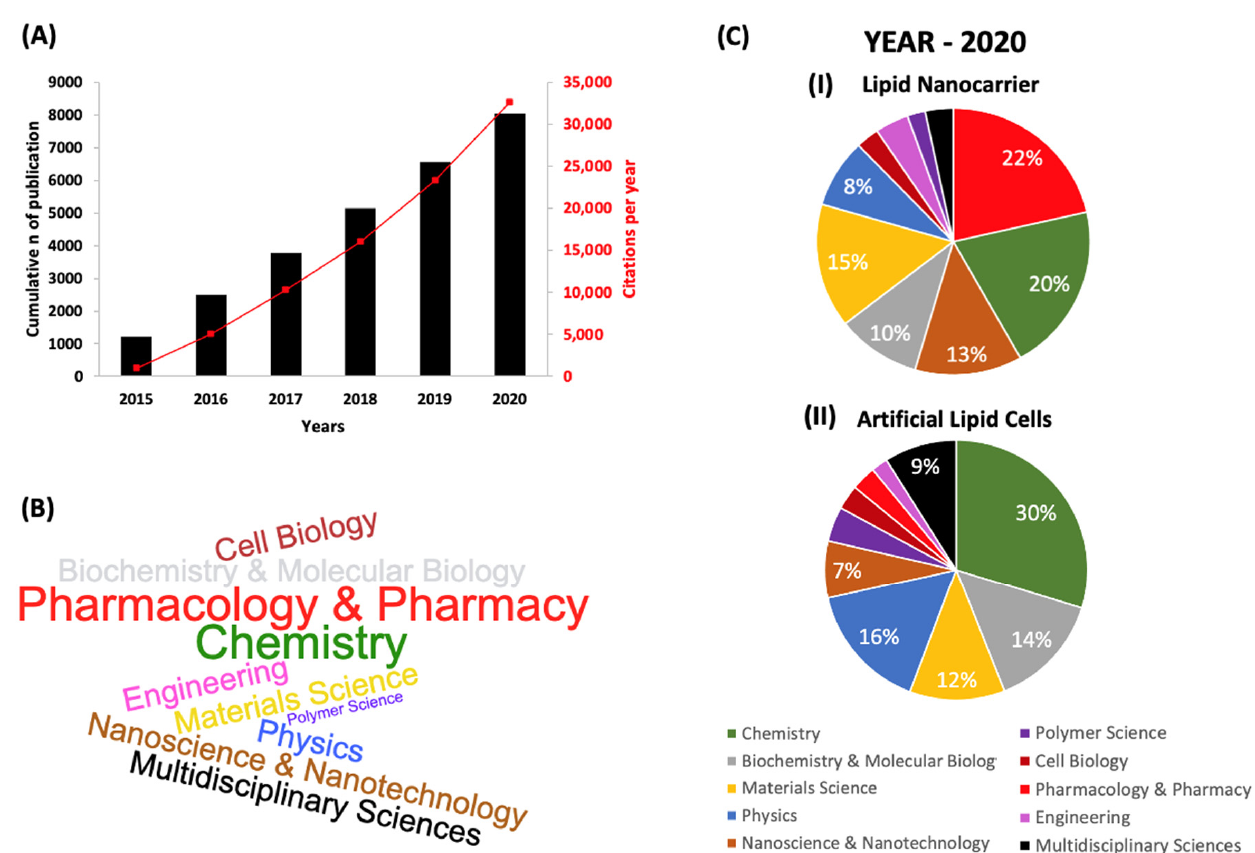
Figure 1. ( A ) Microfluidic publications over the last five years concerning studies with “Microflu- idic*” as a search term along with “Liposome”, “Lipid-nanoparticle”, “Giant Lipid Vesicle or Giant Liposome”, and “Artificial Lipid Cells”. The keywords were searched for on the Web of Science (WoS) analytics report system from Thomson Reuters. The symbol * takes into account permutations of the keyword. ( B ) Word cloud illustrates the most frequently used microfluidics for the synthesis or application of lipid nano-microsystems. The font size is proportional to the number of publications in 2020. ( C ) Pie charts describing the number of microfluidic publications in various disciplines related to ( I ) lipid nanocarriers and ( II ) artificial cells (in 2020). The literature search was performed using WoS to determine the number of microfluidics publications.